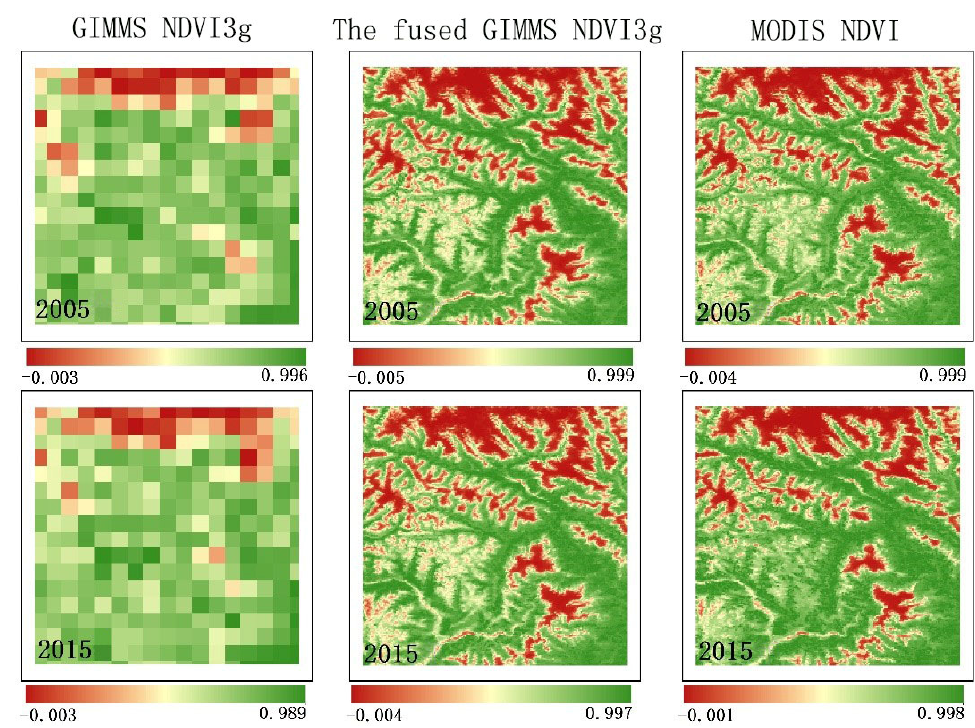
Figure 3. Detail comparison of fused GIMMS NDVI3g and real MODIS NDVI data.